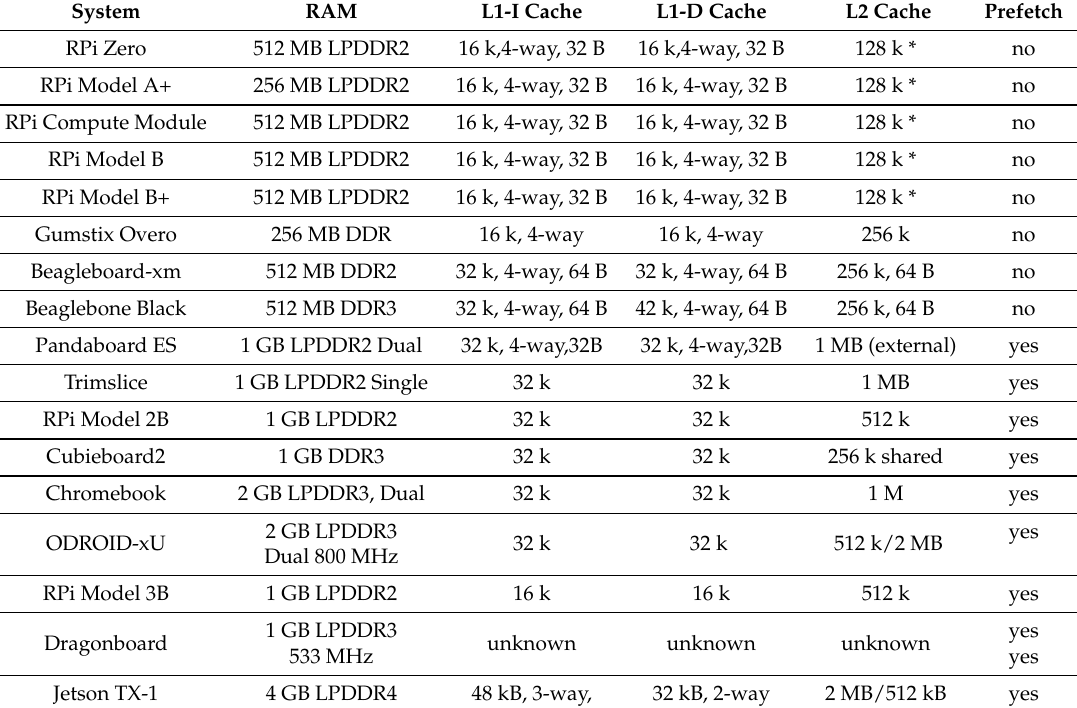
Table A3. Memory hierarchy details for the